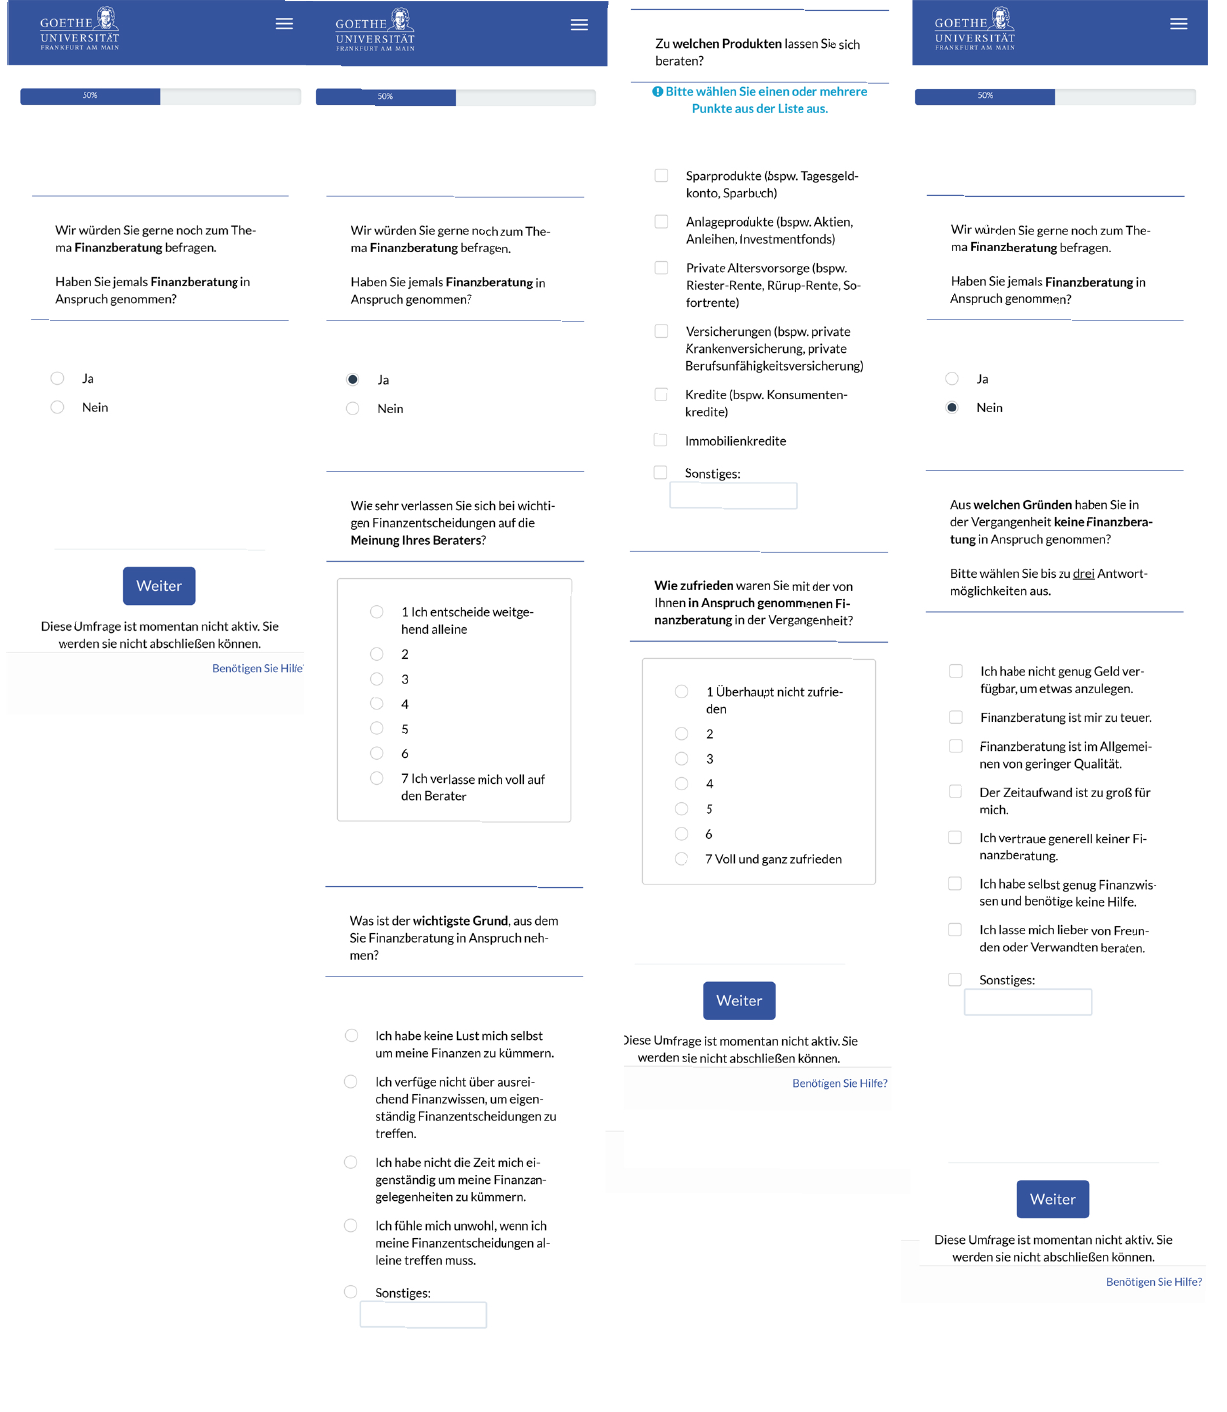
Figure A3. Survey mobile version (page 4–6). Source: Own